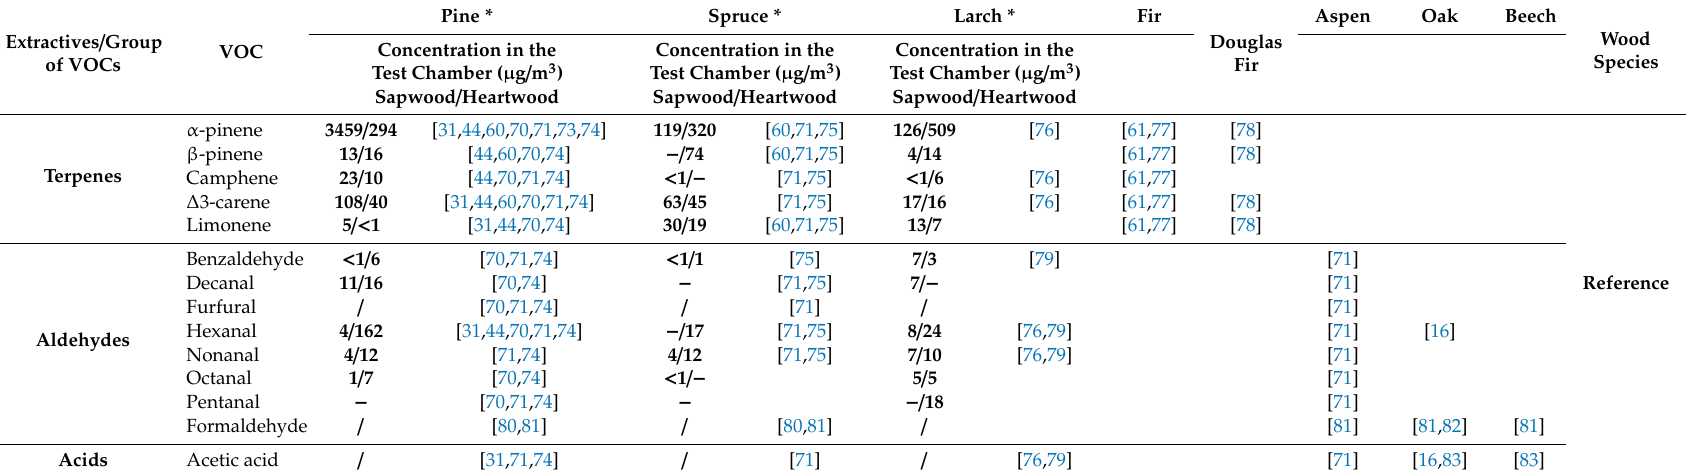
Table 1. VOCs emitted from